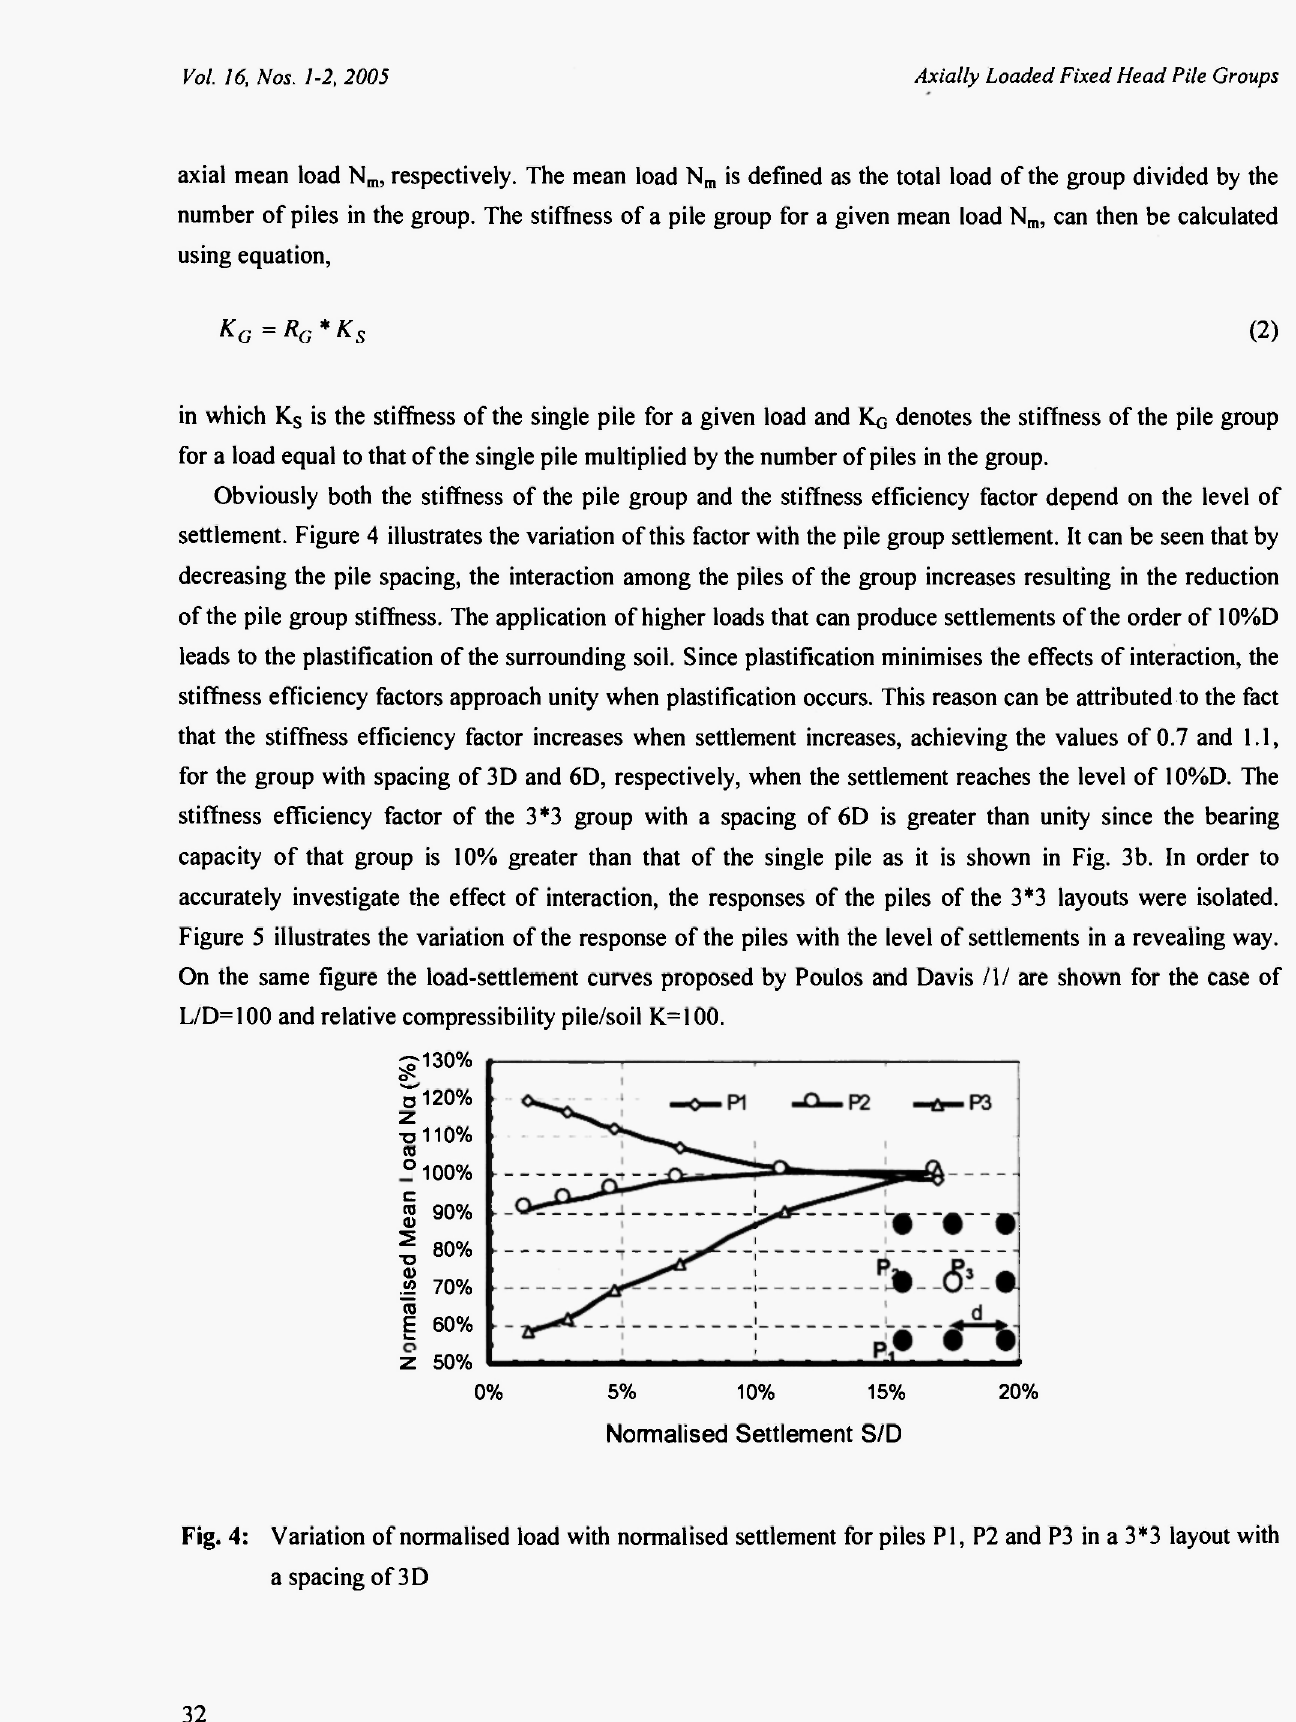
Fig. 4: Variation of normalised load with normalised settlement for piles PI, P2 and P3 in a 3*3 layout with a spacing of